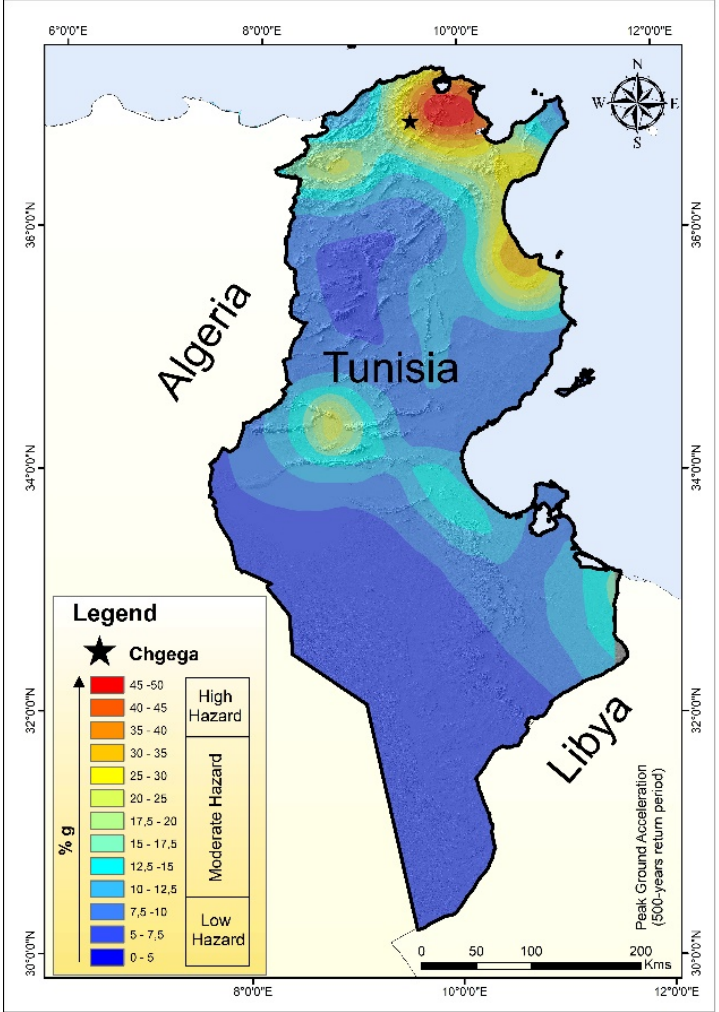
Figure 4. Seismic hazard of Tunisia according to Soumaya et al. [39].